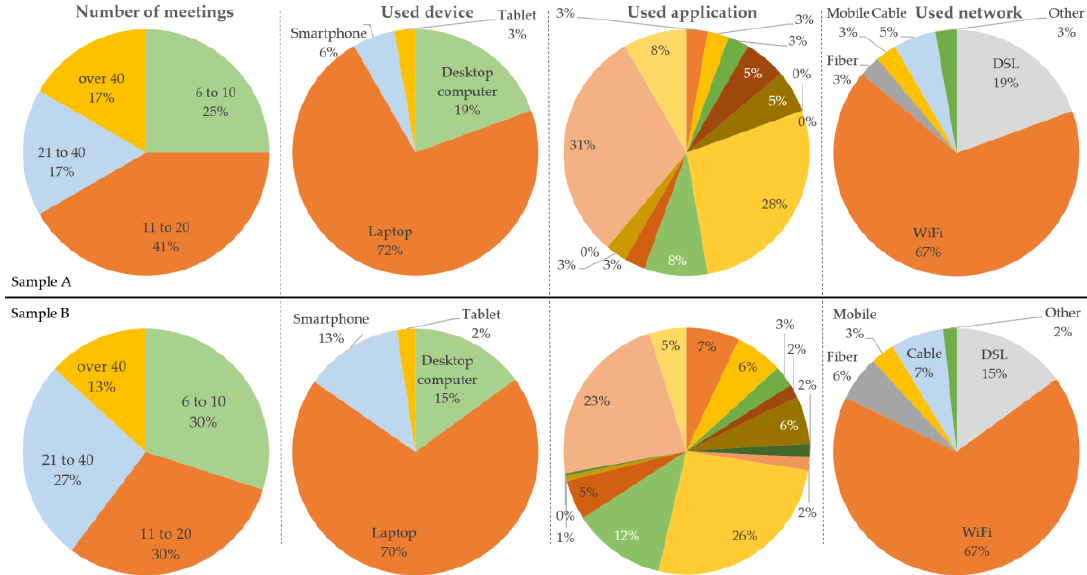
Figure 1. Sample A (top row) and sample B (bottom row) structures were based on the number of attended meetings, devices, applications, and type of network used in telemeetings. For the sake of clarity, in the third column (used application), only the percentages are shown.